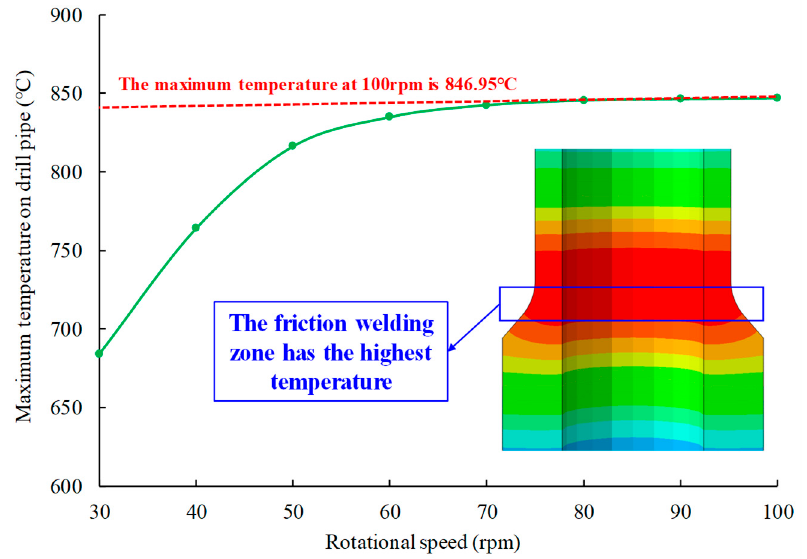
Figure 14. The relation curve between the maximum temperature and the rotational speed of drill pipe. drill